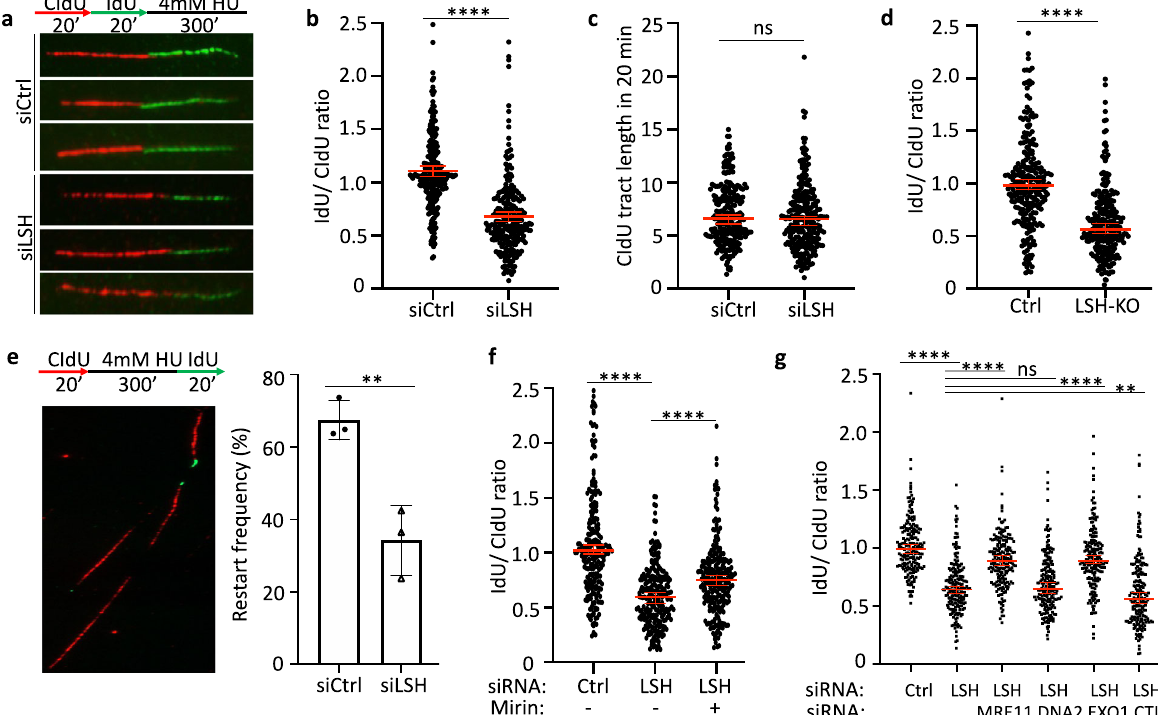
Fig. 2 Reduced nascent DNA protection at stalled replication forks in LSH-de fi cient cells. a Schematic diagram of the fork protection assay (upper panel) and representative images of protected or resected nascent DNA from U2OS cells (lower panel). Cells were sequentially labeled in the indicated times